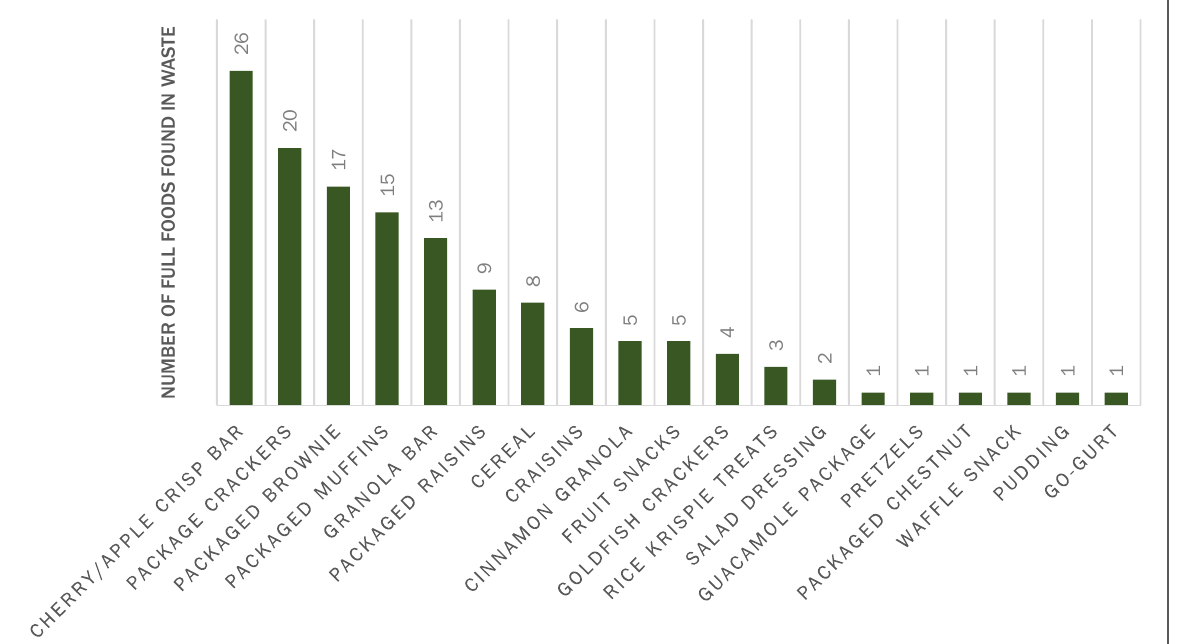
Figure 7. Counts of Miscellaneous Packaged